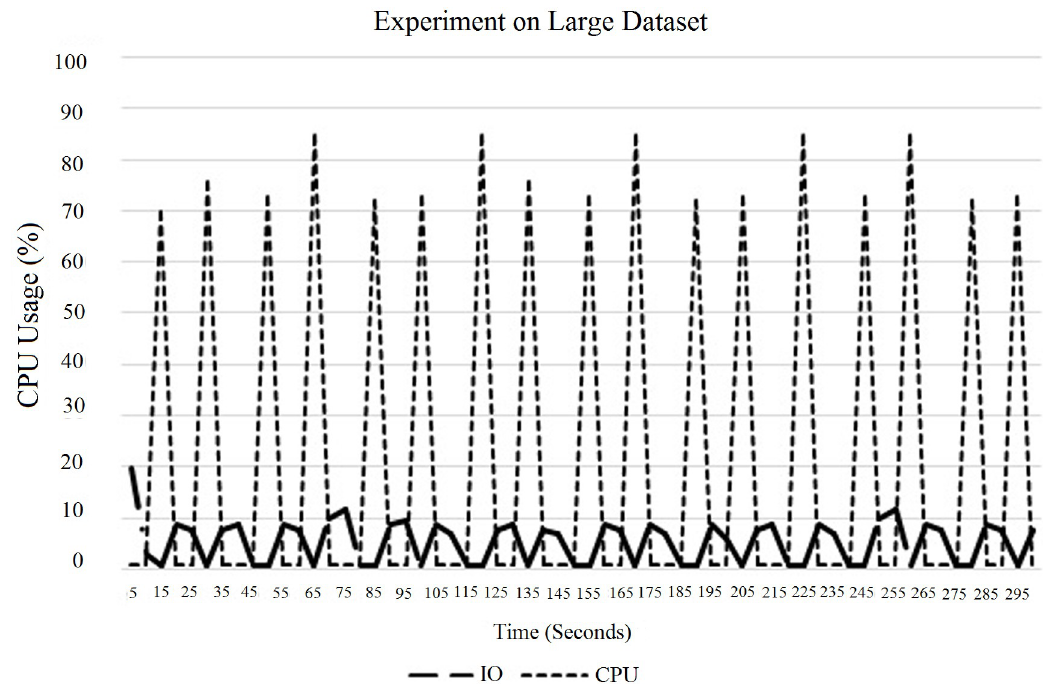
Fig 24. CPU and IO usage on large data-set for a single DataNode with tuned map